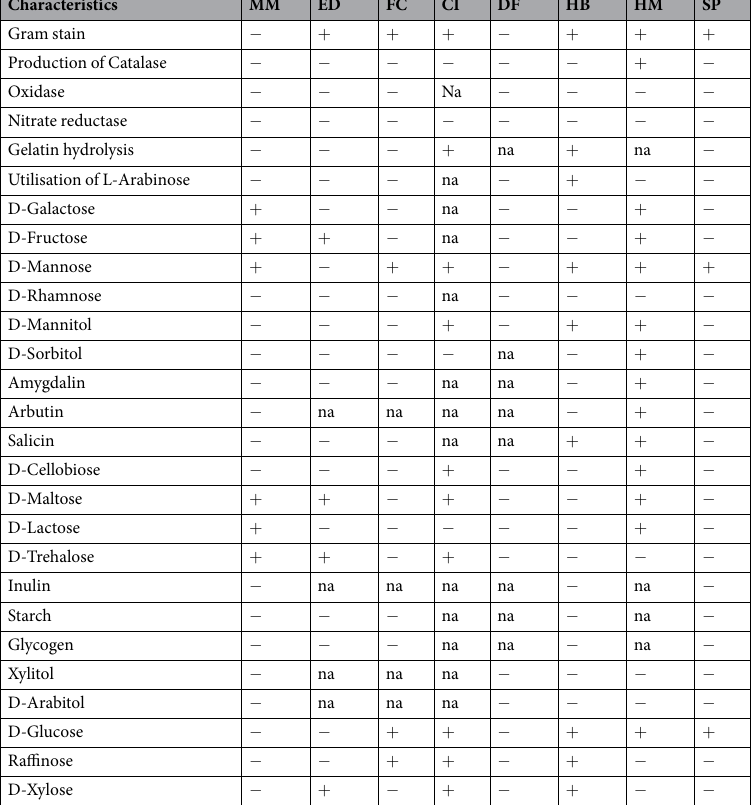
Table 1. Compared phenotypic characteristics of studied species. ED: Eubacterium dolichum; FC: Faecalitalea cylindroides; DF: Dielma fastidiosa; HB: Holdemanella biformis; HM: Holdemania massiliensis: SP: Streptococcus pleomorphus; MM: Merdibacter massiliensis; CI: Clostridium innocuum . Data for reference strains 5,8,10,39–41 . + : positive reaction, − : negative reaction, na: data not